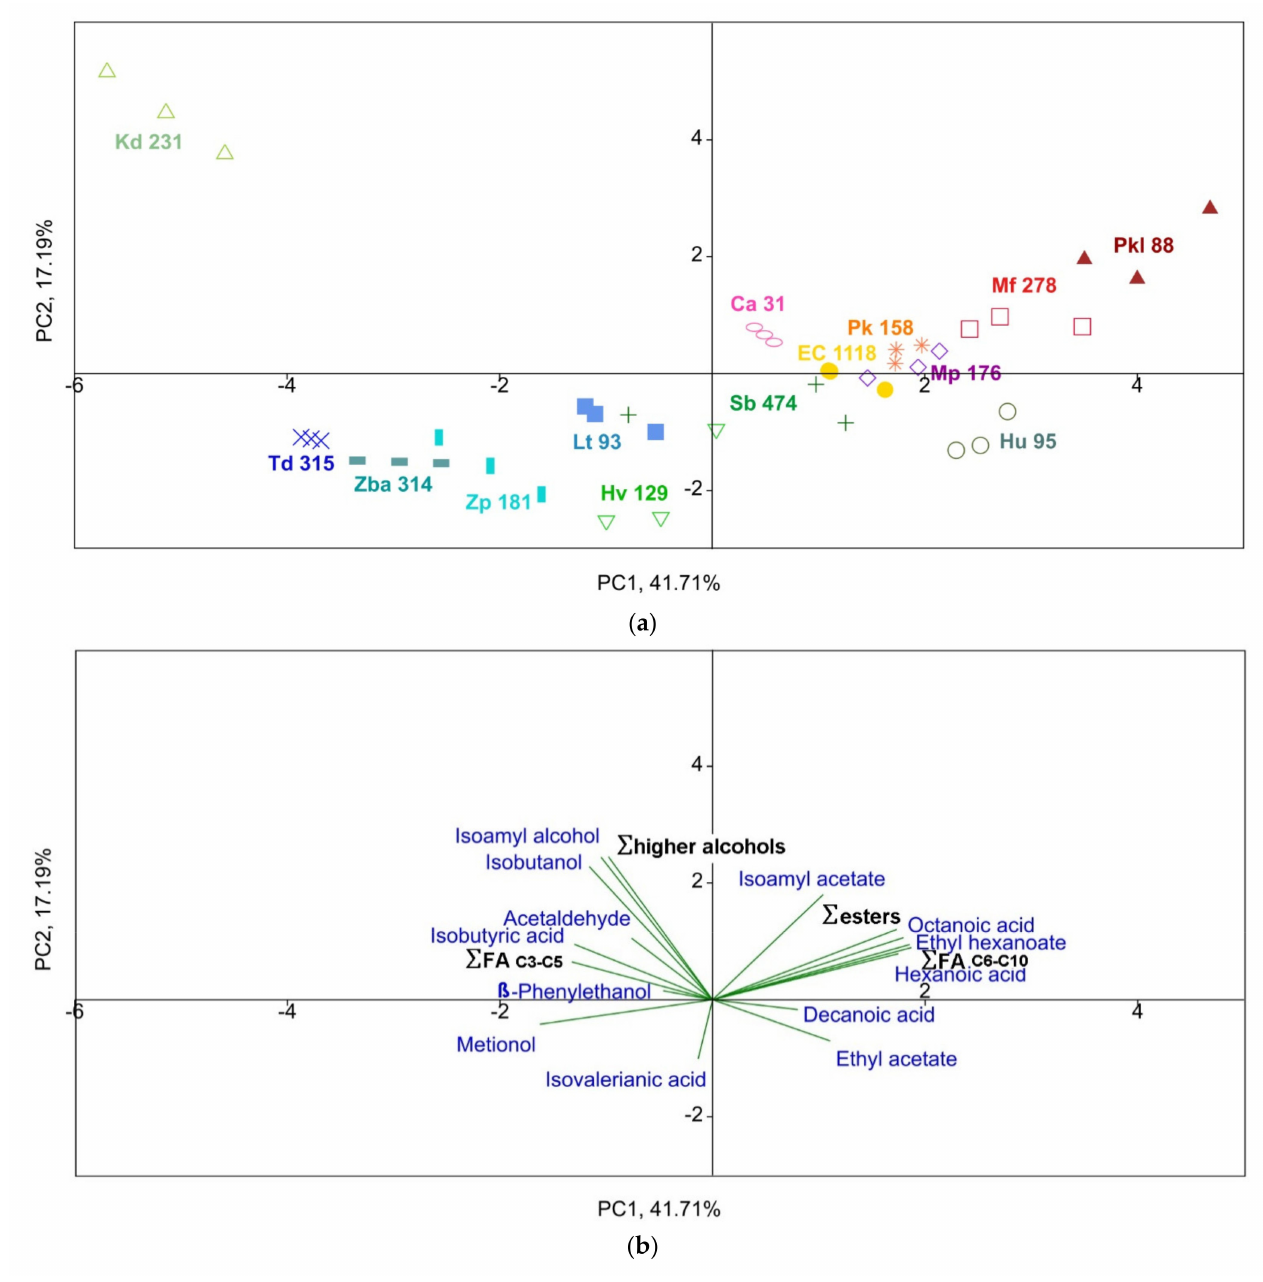
Figure 3. Principal component analysis of wines obtained by sequential fermentation with non- Saccharomyces yeasts + S. cerevisiae EC1118 and with S. cerevisiae as a monoculture based on their volatile composition: ( a ) yeast strain map and ( b ) biplot of the first two components (PC) for compounds with OAV >